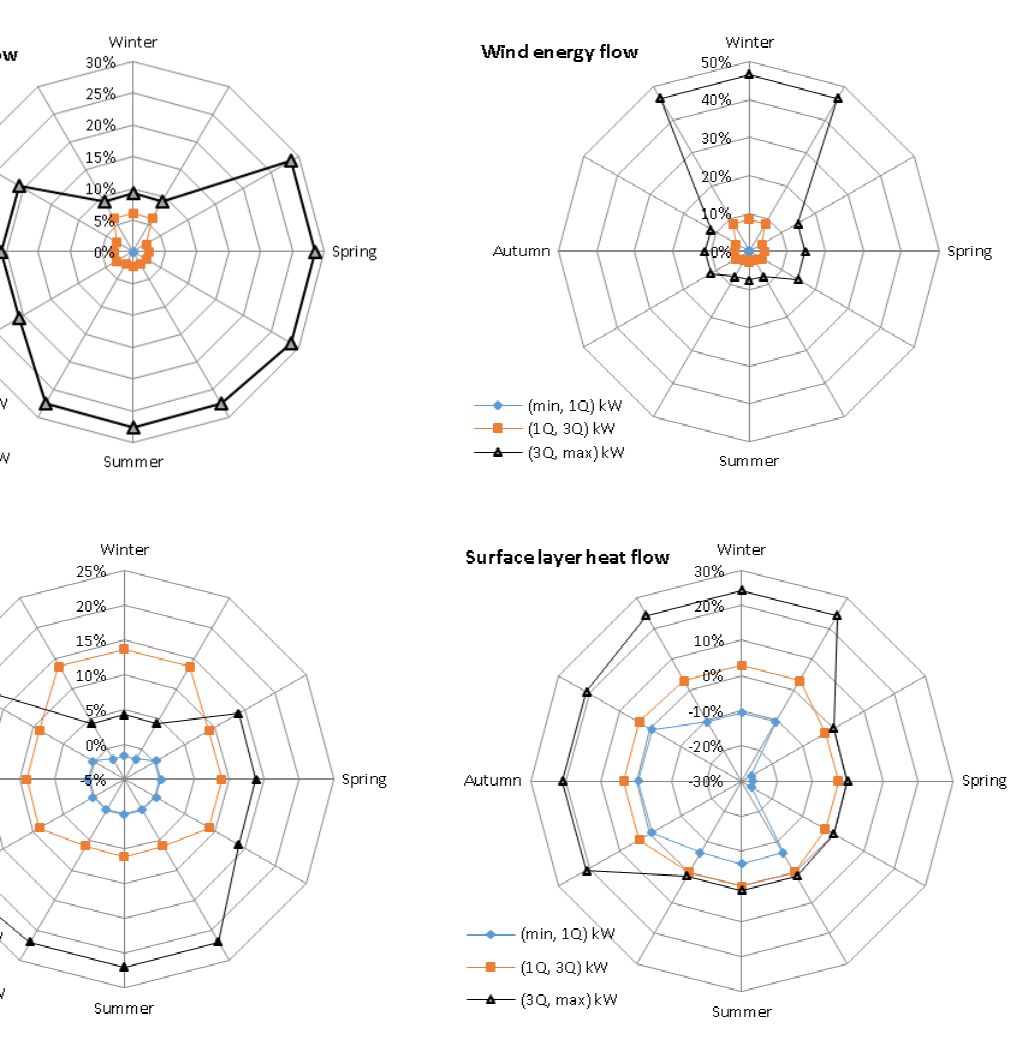
Fig. 8. Frequency of energy flow values throughout